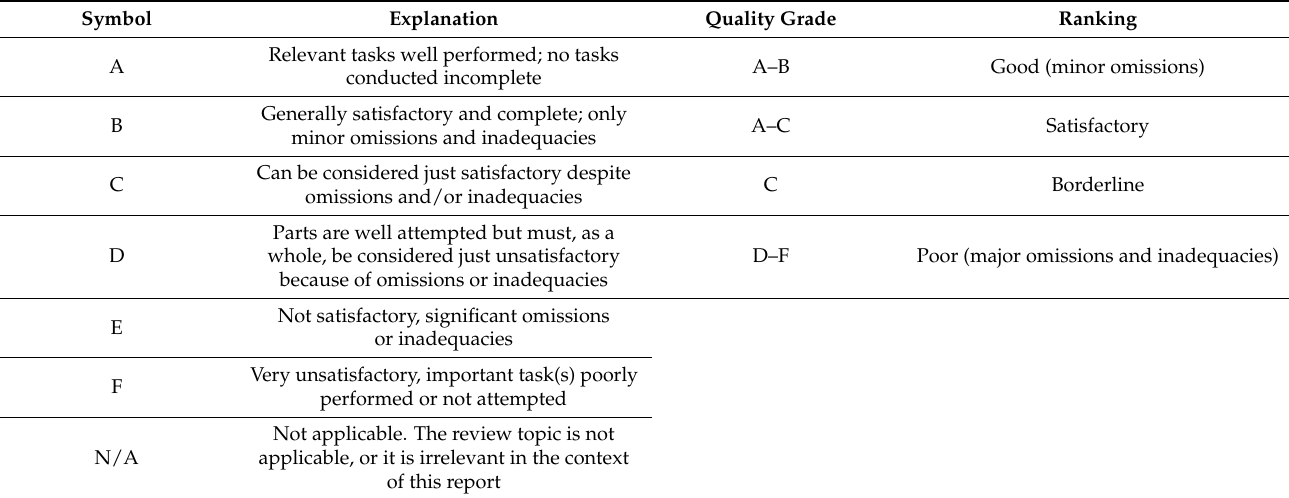
Table 2. Various grades of EIAR